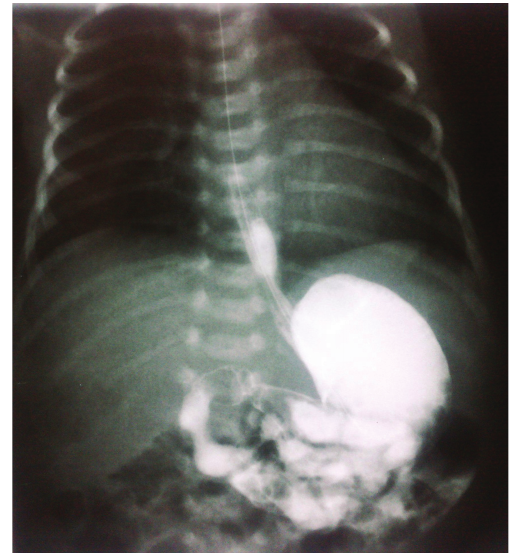
Figure 2: Upper gastrointestinal study with gastrografin shows an incomplete obstruction on jejunoileal